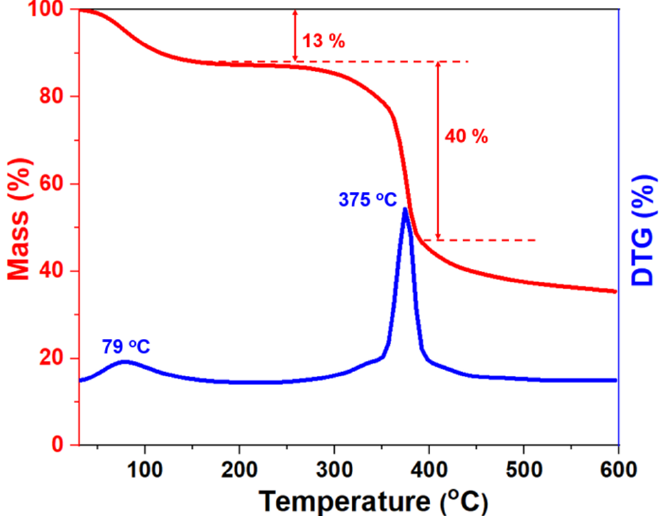
Figure 3. TGA and DTG curves of NS-ANAD co-polymer.